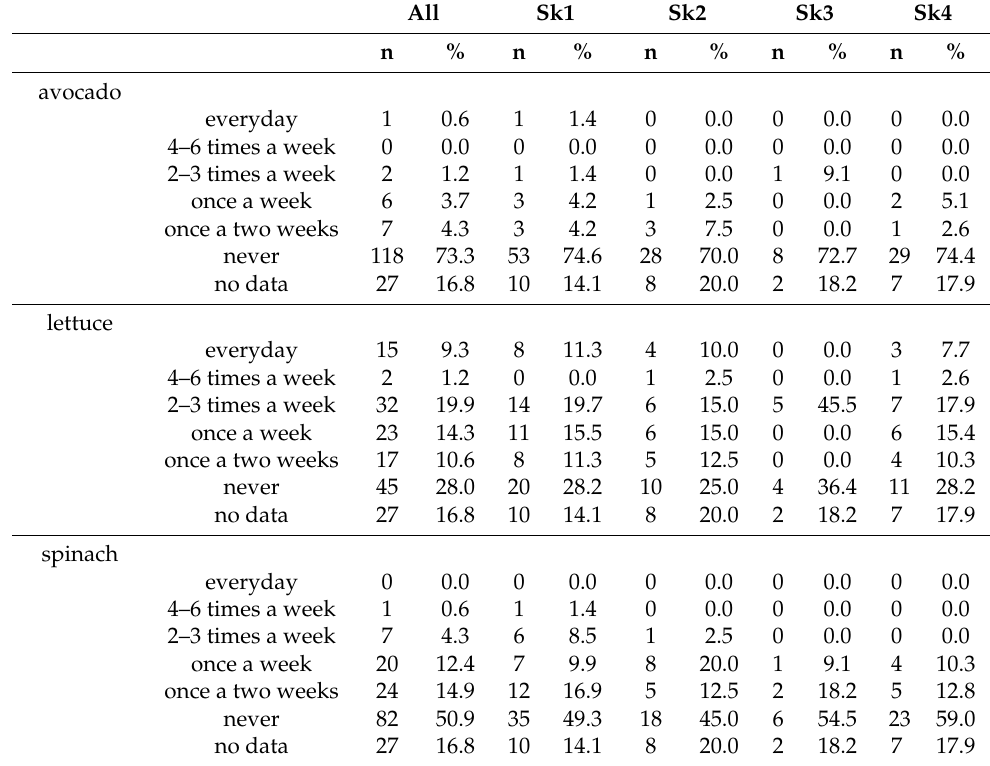
Table A8. Selected food products consumption and diet supplementation among investigated